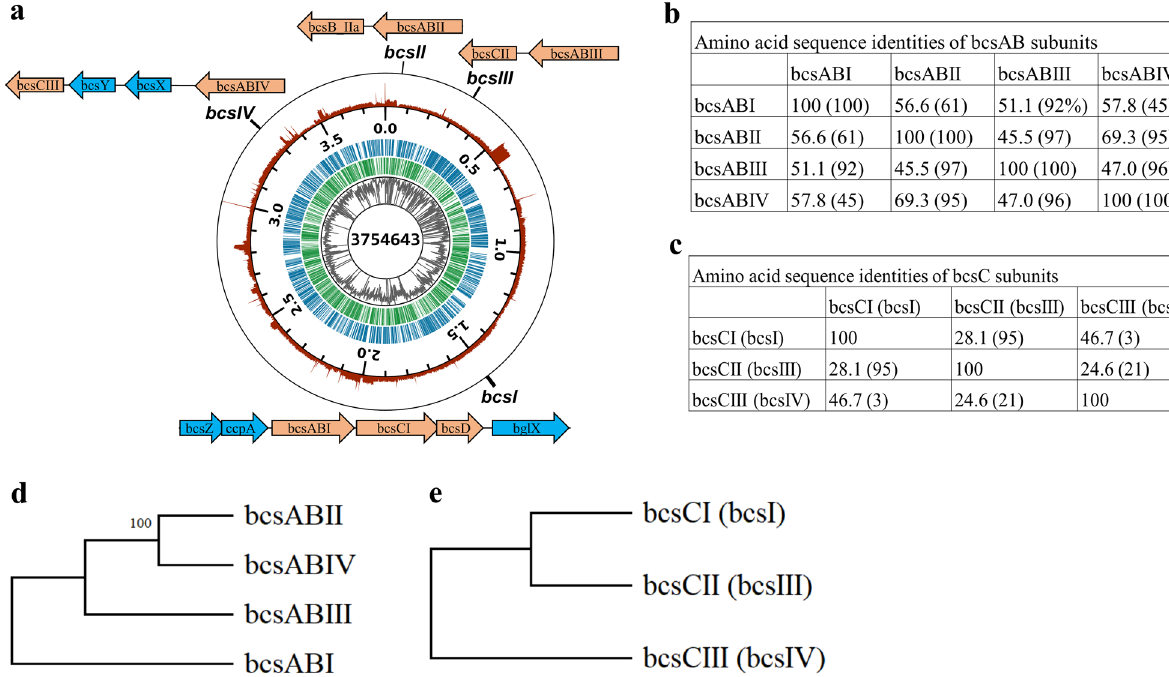
Figure 2. K. intermedius ENS15 genome. ( a ) Genome map. The genome contains one chromosome of 3,754,643 bp (GC content 61.8%) with a predicted total of 3467 genes, 120 repeat DNA, 47 tRNAs and 19 non- coding RNA. The displayed data from perimeter to center are, coverage (red), chromosome position (major ticks 500 kbp, minor ticks 100 kbp), forward strand CDSs (in the middle, blue), reverse strand CDSs (in the middle, green), GC-percentage (gray), and chromosome size (bp). The GC-percentage ranged from 17.6 to 69.8% and coverage (number of reads mapping to the locus) from 653 to 14,700. Both GC-percentage and coverage were calculated with 1 kbp window size. Coverage is displayed with logarithmic scaling. The genome map was prepared by matplotlib 34 (3.3.4; https:// matpl otlib. org/3. 3.4), pysam 0.15.3 (https:// github. com/ pysam- devel opers/ pysam), and biopython 35 (1.78; https:// biopy thon. org/ docs/1. 78) libraries using python language (3.7.11; https:// www. python. org/). The bcs operon and the surrounding genes are indicated by manually curated figures directing to its position in the genome. ( b,c) and ( d,e) respectively indicates the amino acid sequence identities (MUSCLE program 29 ) and the phylogenetic relationship between the predicted bcsAB and bcsC genes present in genome. The phylogenetic tree was build using MEGA X integrated tool 14 (https:// www. megas oftwa re. net/, version